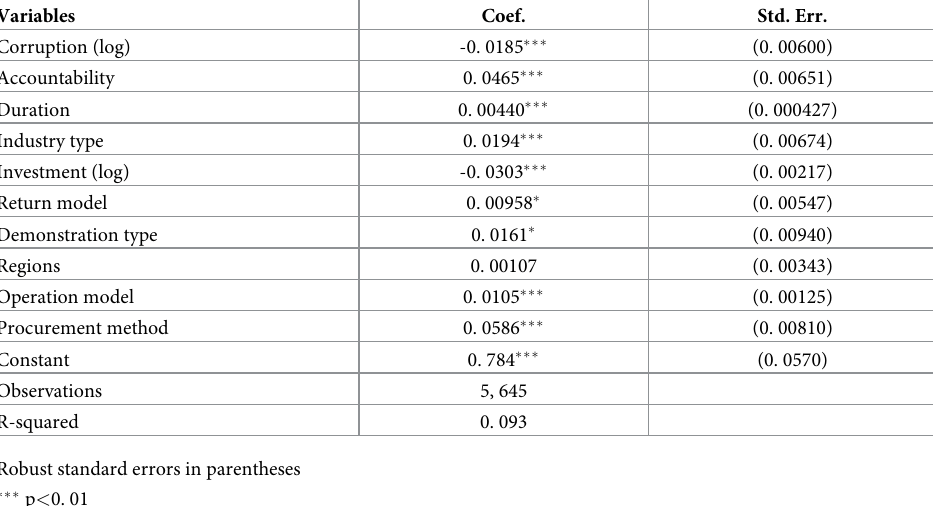
Table 4. Baseline regression